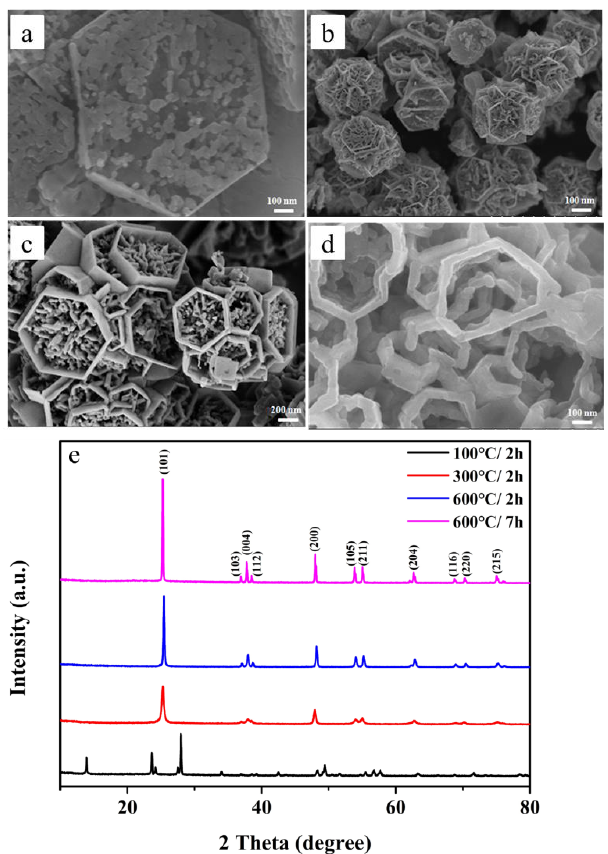
Figure 3. SEM images of TiO 2 synthesized with different calcined temperatures: ( a ) 100 °C/2 h; ( b ) 300 °C/2 h; ( c ) 600 °C/2 h; ( d ) 600 °C/7 h. ( e ) XRD patterns of TiO 2 synthesized with different calcined conditions. Note: 100 °C/2 h, the precursor calcined at 100 °C for 2 h; 300 °C/2 h, the precursor calcined at 300 °C for 2 h; 600 °C/2 h, the precursor calcined 600 °C for 2 h; 600 °C/7 h, the precursor calcined 600 °C for 7 h.